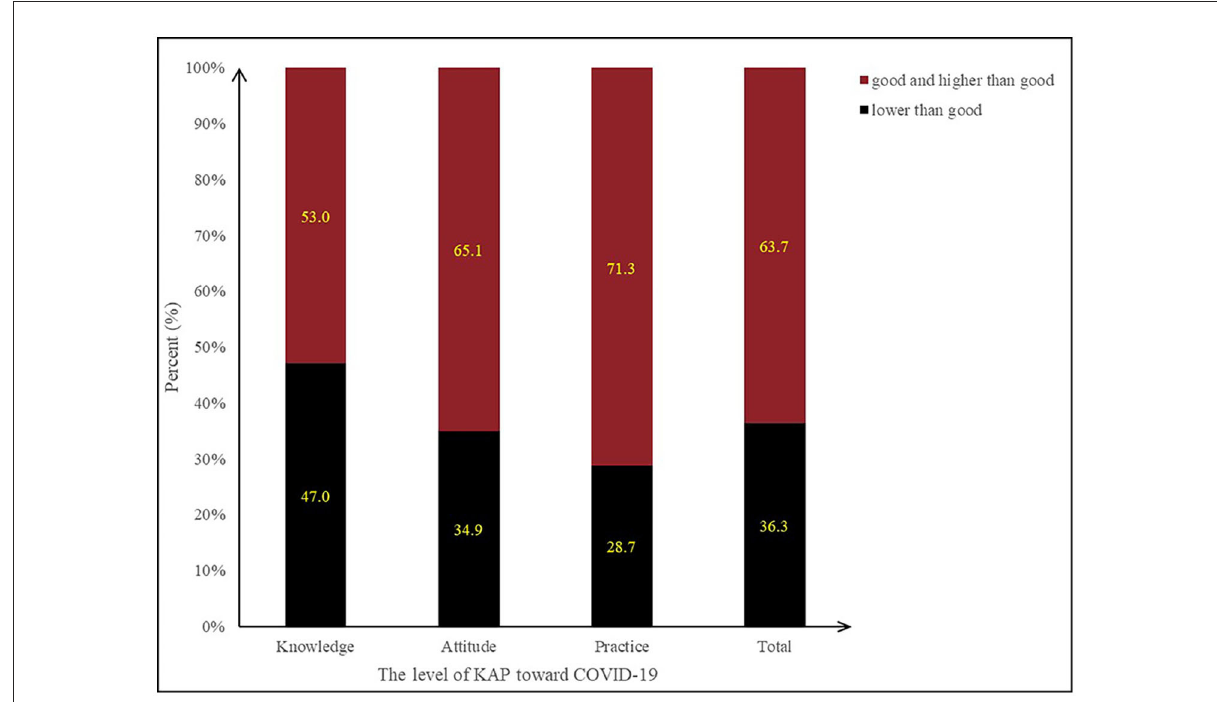
FIGURE3 Participants’ total KAP levels toward COVID-19 and levels for the three KAP